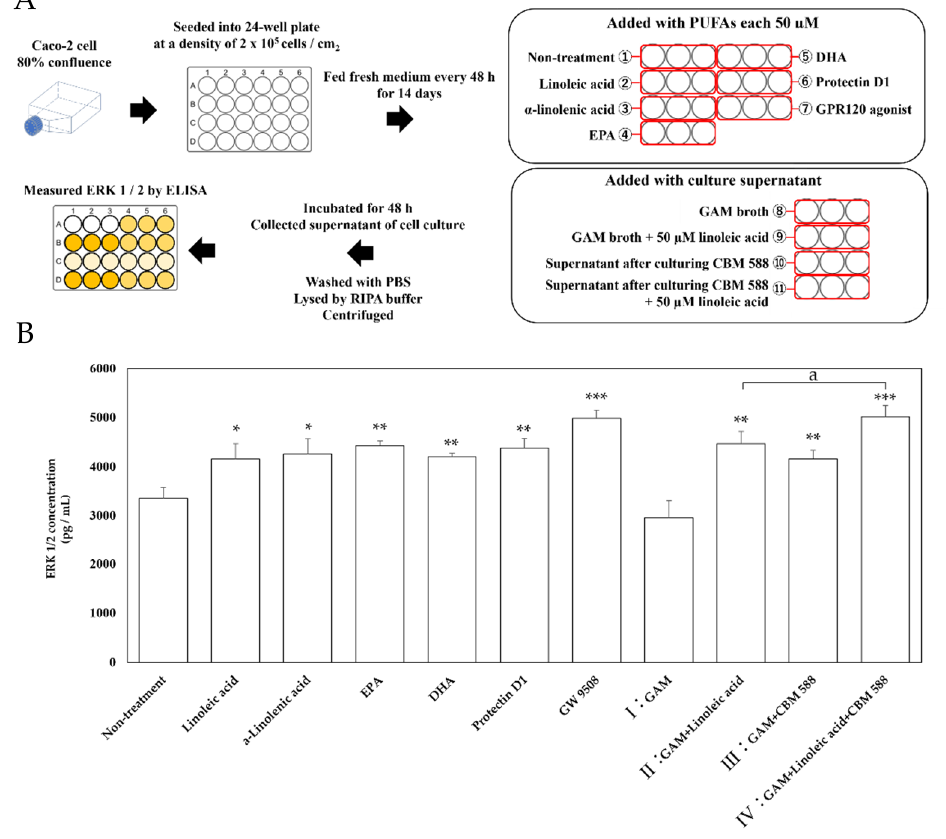
Figure 5. ERK 1/2 concentration in Caco-2 cells after ligand stimulations. ( A ) Experimental design of in vitro study with Caco-2 cells. Caco-2 cells were cultured at 37 ◦ C in 75 cm 2 tissue culture flasks to 80% confluence and then seeded into a 24-well micro plate at a density of 2 × 10 5 cells / cm 2 . After 14 days of culture, the Caco-2 cells were treated with PUFAs (linoleic acid, α -linolenic acid, EPA and DHA each 50 µ M), GPR120 agonist GW 9508, CBM 588 free culture medium (I: GAM broth and II: GAM broth supplemented with 50 µ M linoleic acid, same samples as described in Section 2.12), and CBM 588 culture supernatant (III: supernatant after culturing CBM 588 in GAM broth and IV: supernatant after culturing CBM 588 in GAM broth supplemented with 50 µ M linoleic acid, as described in Section 2.12), and the Caco-2 cells were incubated for 48 h. Protein expression levels of ERK 1/2 in the supernatants were measured with commercially available mouse ELISA kits. ( B ) Changes in ERK 1/2 activity by addition of fatty acid ligands, culture broth with or without linoleic acid, and CBM 588 to Caco-2 cells. The vertical axis shows concentration (pg/mL). The values represent the mean ± SD ( n =3, red circle mark). The calculated probability was considered statistically significant at p < 0.05. *: p < 0.05 compared with control. **: p <0.01. ***: p <0.001. a: p < 0.05 compared with II (GAM broth supplemented with 50 µ M linoleic